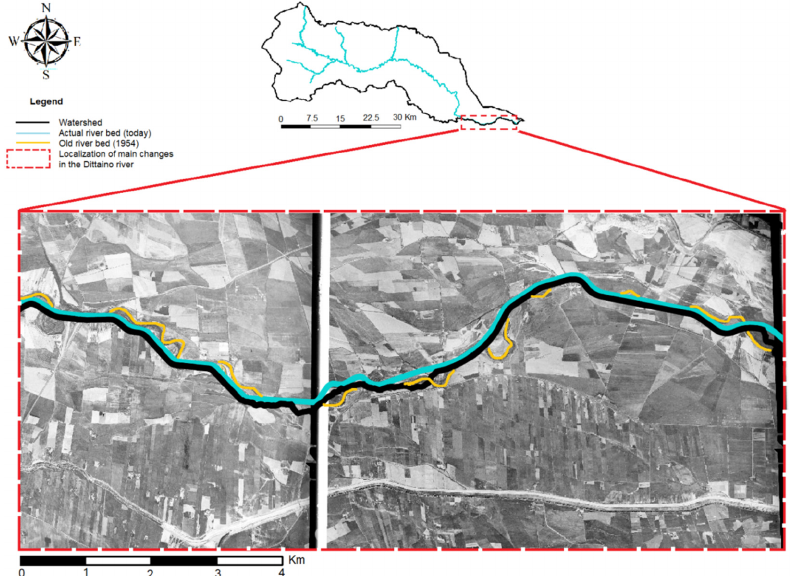
Figure 2. Comparison between remote sensing images (Orthophotos 2008) and maps of the flight IGM GAE of